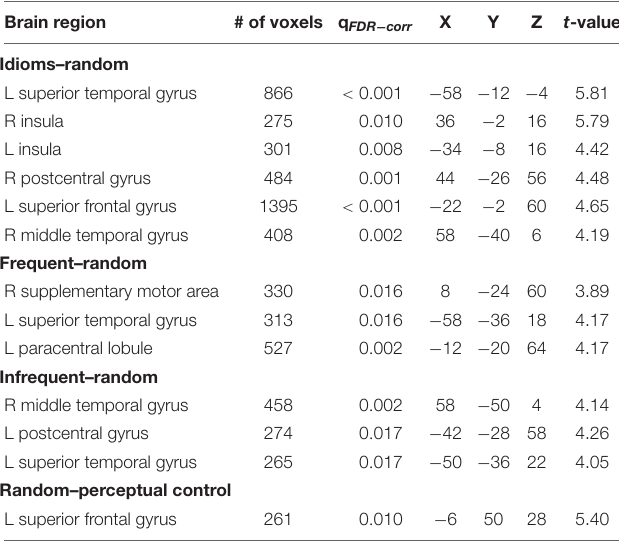
TABLE 3 | Peak activation details of brain areas with higher contrast responses in older than younger adults. Brain